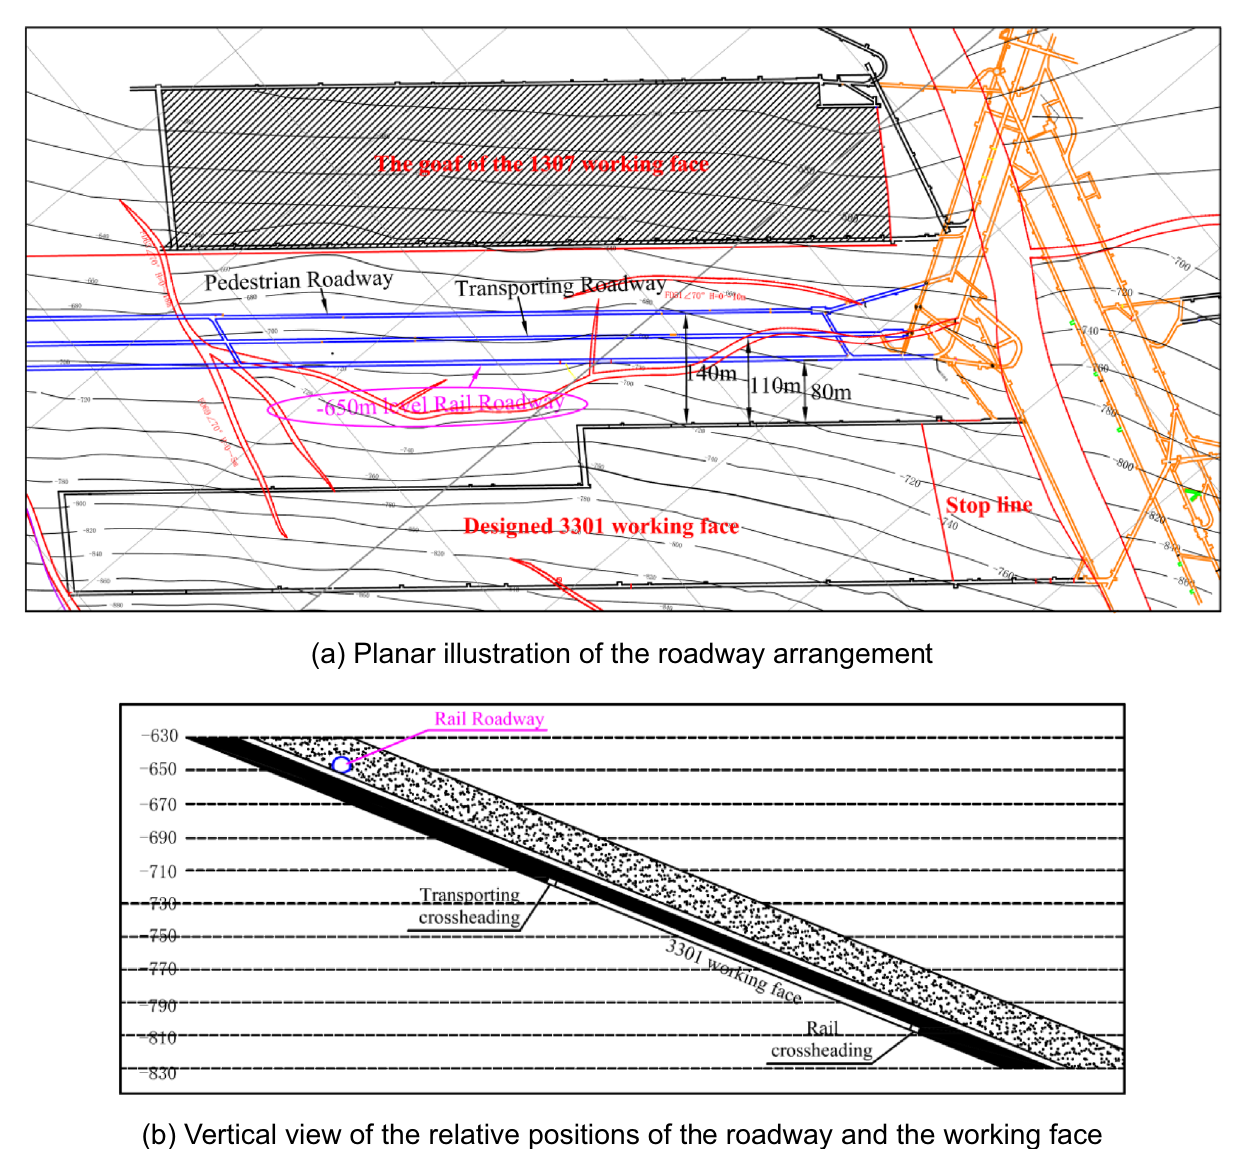
Figure 7. The planar and vertical views of the roadway